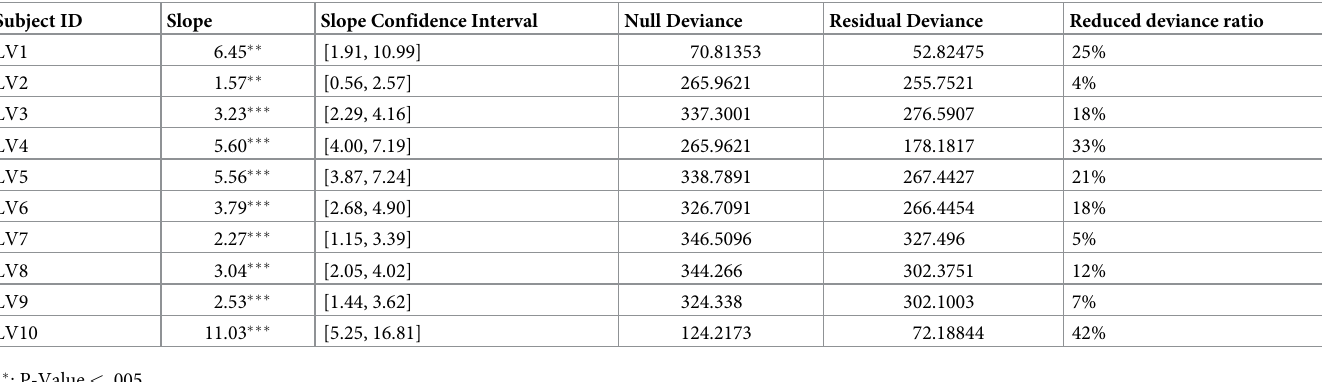
Table 3. Individual regression models of low-vision